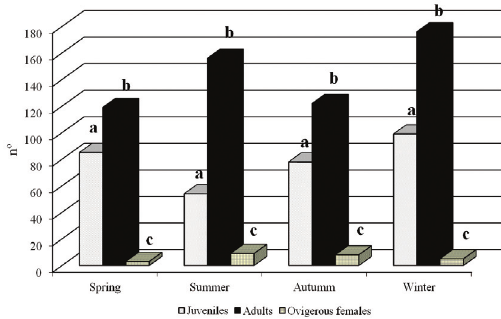
Figure 4. Aegla manuinflata : Relative frequencies of juveniles, adults and ovigerous females sampled in the four seasons of the year in the Passo taquara stream, São Pedro do Sul, Rio Grande do Sul state, Brazil (same let- ters indicate absence of significant differences between the frequencies of the categories between the seasons of the year [ANOVA; p >